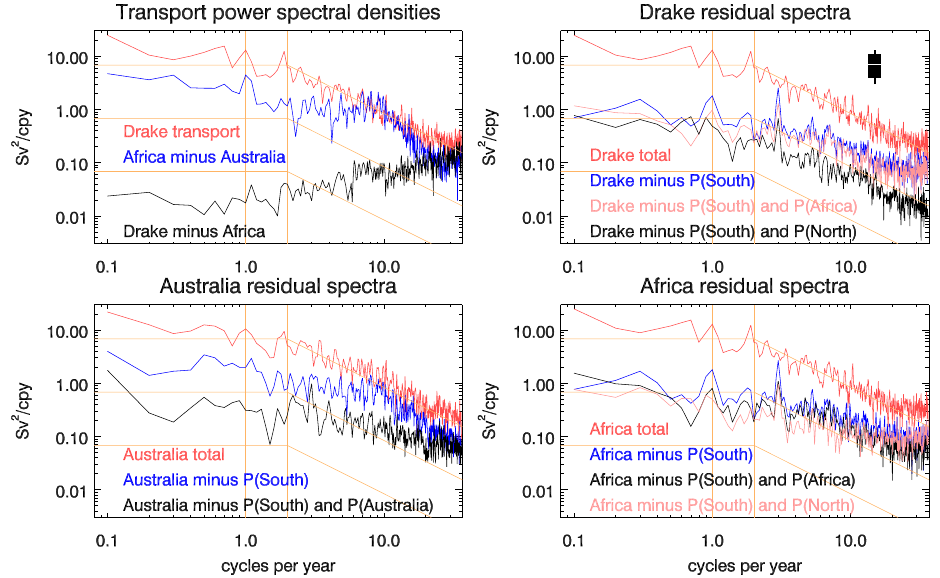
Fig. 8. Power spectra associated with variations in transport through Drake Passage, south of Africa, and south of Australia, from the 1 / 4 ◦ model. The top left panel shows the spectrum of Drake Passage transport (red), that of the difference between Drake Passage transport and transport south of Africa (black), and that of the difference between transports south of Africa and Australia (blue). Other panels show the spectrum of transport through each section (red), of the residual after subtracting the transport accounted for by southern boundary pressure (blue) and of the residual after subtracting the transport accounted for by southern boundary pressure and the corresponding northern boundary pressure (black). Pink curves are like the black curves but use a northern boundary pressure from a different section. Orange lines are for guidance only and show representative spectra separated by factors of 10, together with the annual and semiannual frequencies. The Drake residual plot includes a scale bar for the uncertainty (95% and 99%) to be applied at each individual frequency (band averages have smaller